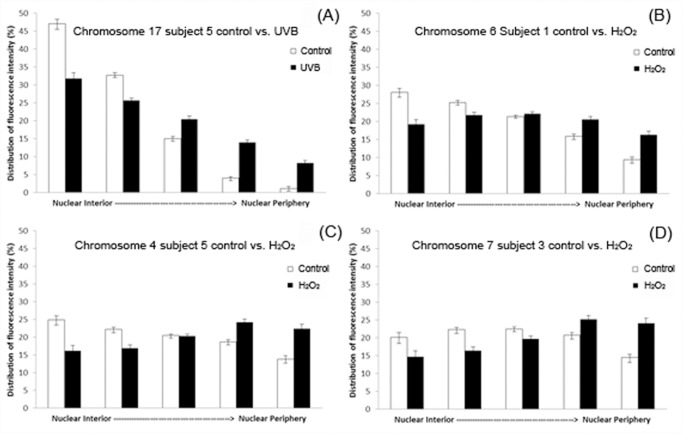
Chromosome repositioning events following exposure to genotoxic agents.All four panels (A-D) depict the different types of CT repositioning observed in human lymphocytes following exposure to genotoxic agents H2O2 and UVB compared to control (unexposed) cells. In all four panels the X axis shows the five shells of equal area from the nuclear interior to the nuclear periphery (left to right) and the Y axis shows the percentage of fluorescence for each CT that lies within each of the five shells after analysis of 100 cells. Error bars represent the standard error of the mean (SEM). Examples for each of the four different categories of statistically significant chromosome repositioning described in Table 1 are provided: (A) “less interior” localization of chromosome 17 in subject 5 following UVB exposure compared to control cells; (B) interior to intermediate positioning of chromosome 6 in subject 1 following H2O2 exposure; (C) interior to peripheral positioning of chromosome 4 in subject 5 following H2O2 exposure; and (D) intermediate to peripheral positioning of chromosome 7 in subject 3 following H2O2 exposure.